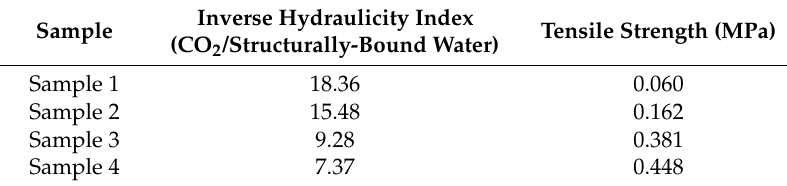
Figure 8. Correlation of tensile strength and inverse hydraulicity index. Table 3. Correlation of physicochemical data with tensile